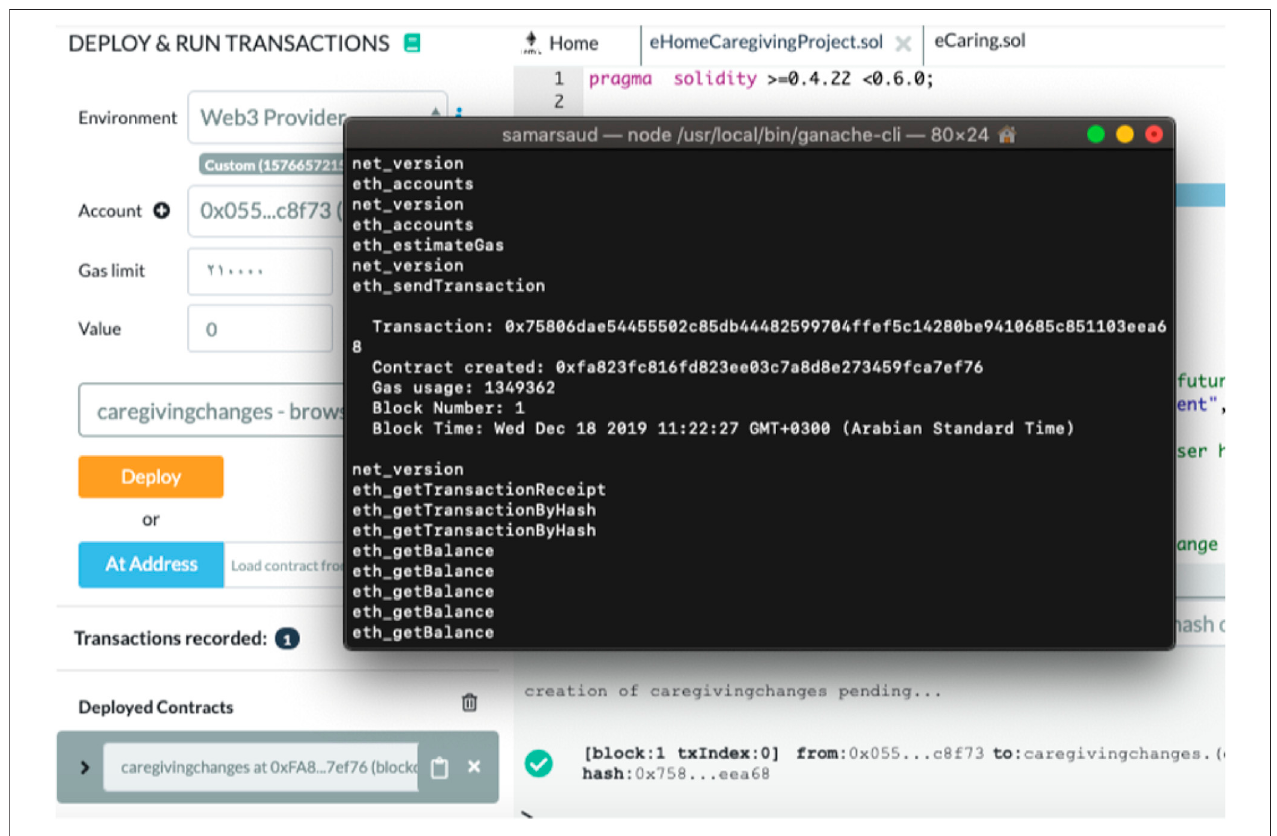
FIGURE 14 | First transaction in blockchain when smart contract created.